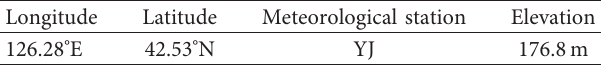
Table 4: Moisture balance calculation